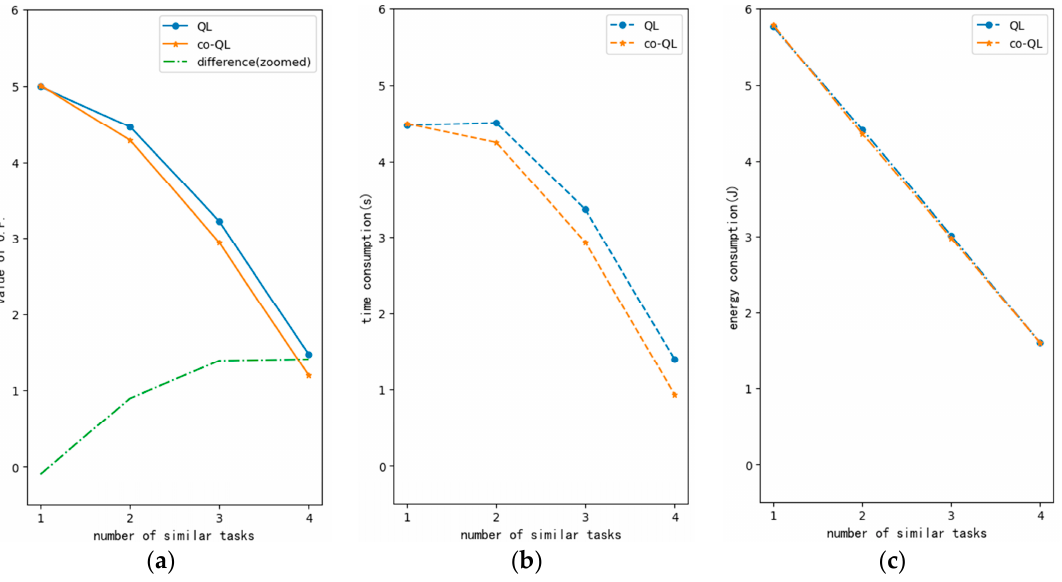
Figure 10. Performance curve of QLs with different task similarities (M = 4, N = 4, G = 1): ( a ) curve for value of objective function; ( b ) curve for time consumption; ( c ) curve for energy consumption.